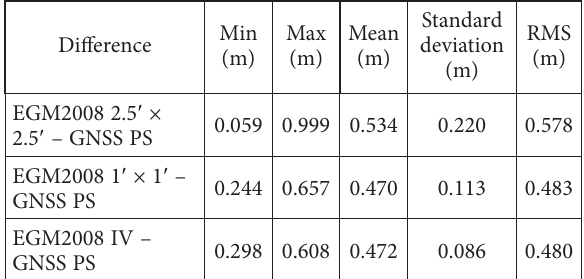
Figure 4. The final local geoid model (horizontal coordinates are in